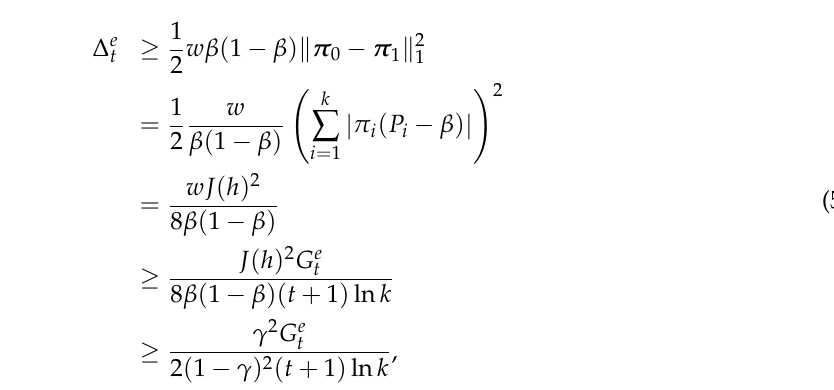
(cid:17) (cid:16) (cid:16) 1 + ( 1 − π π 1 ln π 1